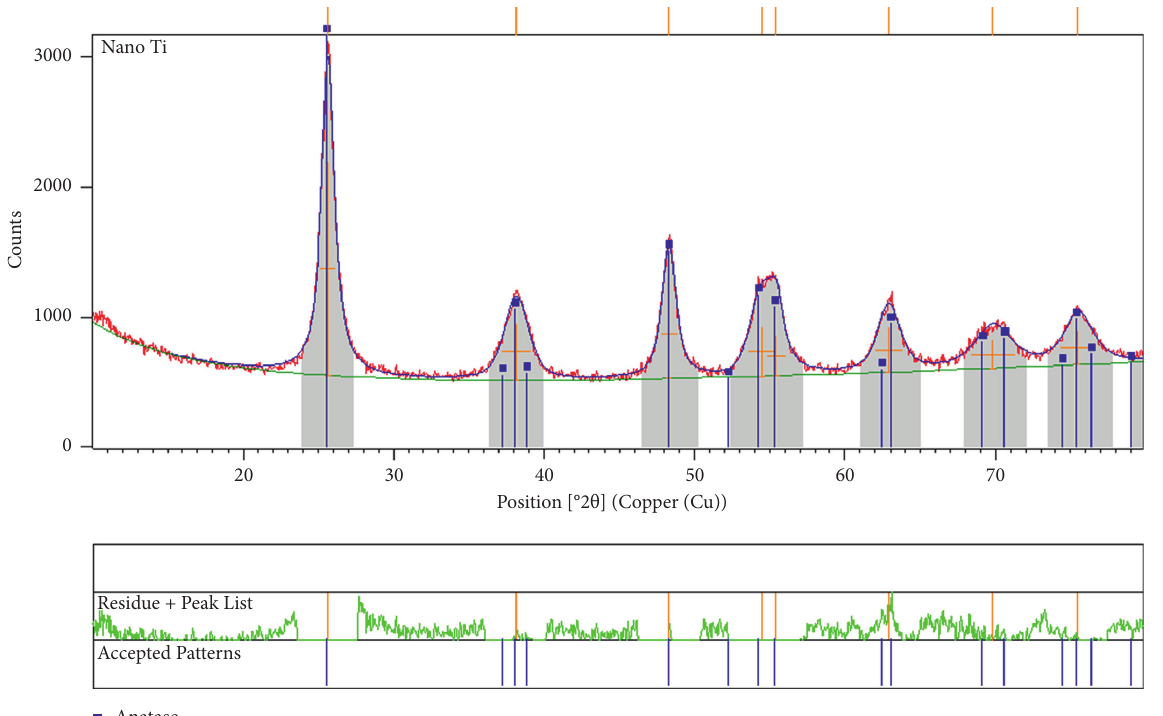
Figure 5: XRD peaks of Nano TiO